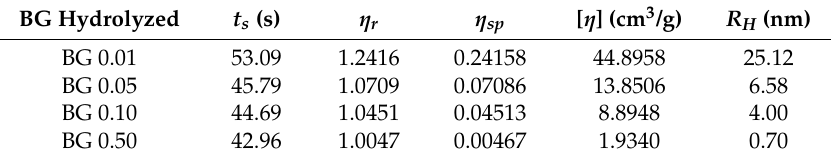
Table 4. Molecular weight determinates for intrinsic viscosity by BG